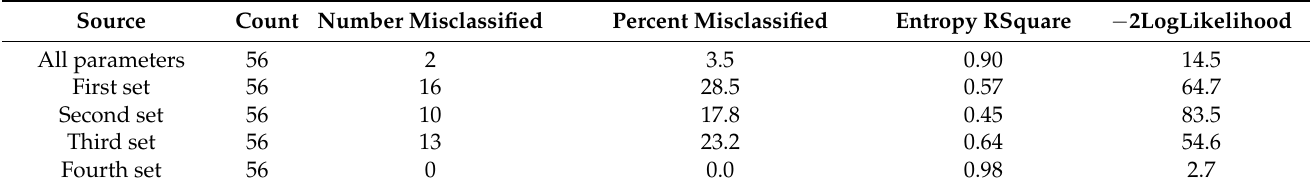
Figure 4. The 3D canonical plot of QDA results in discrimination of four groups based on the first set of characteristics, including Shoot L, Shoot N, Leaf A, RWC, and Ch a. Table 3. Number and present age of misclassification, entropy RSquare and likelihood ratio for each set of traits used for classification of grapevine cultivars.